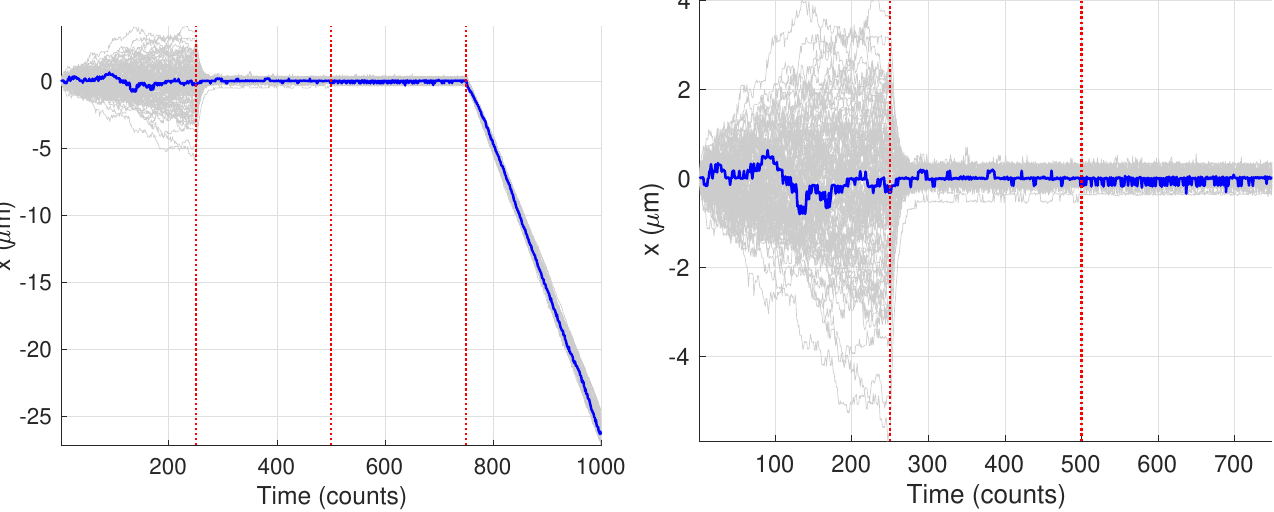
Figure 9. Synthetic motion trajectories generated from image data over ( left ) the full 1000 frames and ( right ) over the first 750 frames to highlight the diffusive nature of the motion. The example trajectory used is highlighed in blue. Vertical red dashed lines are where the model values changed according to the values in Table